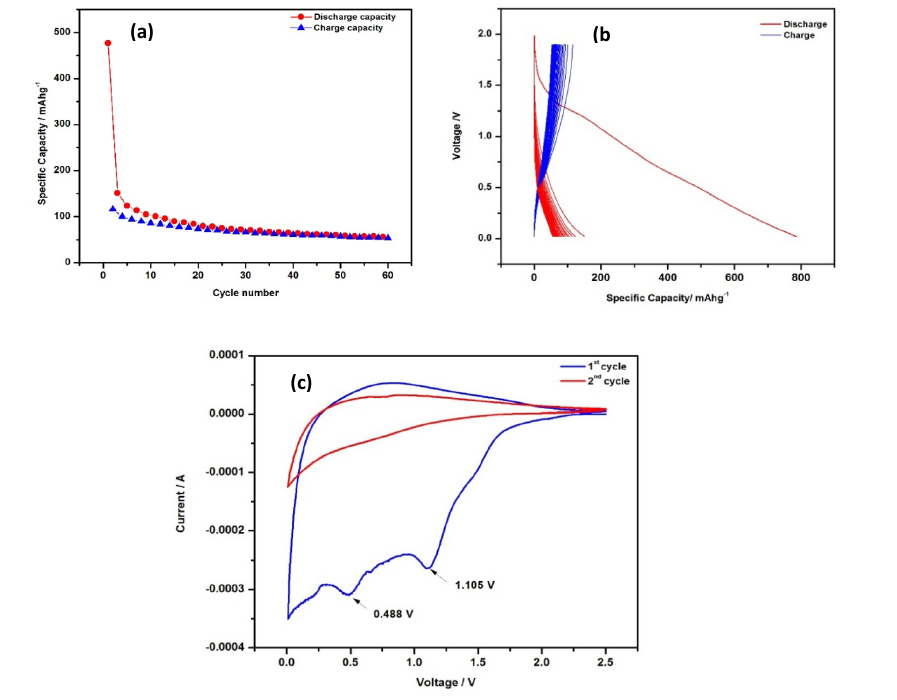
Figure 3: Electrochemical performance of Na rate of C/10. (b) Initial galvanostatic charge-discharge curves at a current rate of C/10 in the voltage range of 0.02-1.9 V verses Na + / Na. (c) Cyclic Voltammograms of Na